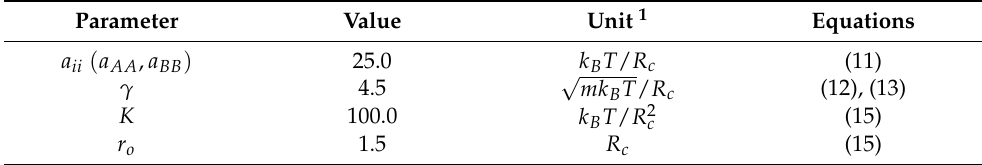
Table 1. The list of the DPD parameters used in the present study. Parameter Value Unit 1